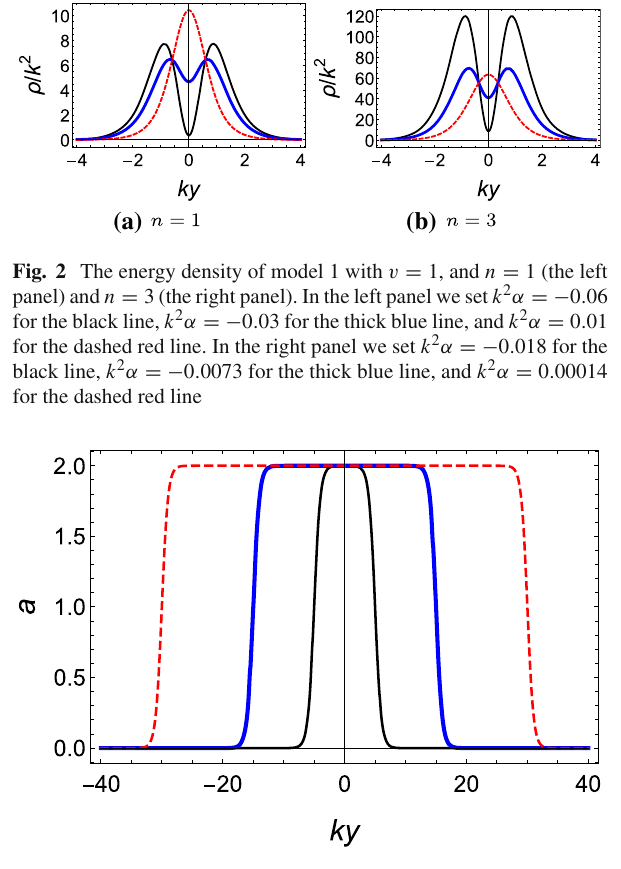
Fig. 3 The warp factor of model 2. The parameter v is set to v = 1, and kb = 5 for the black line, kb = 15 for the thick blue line, and kb = 30 for the dashed red line